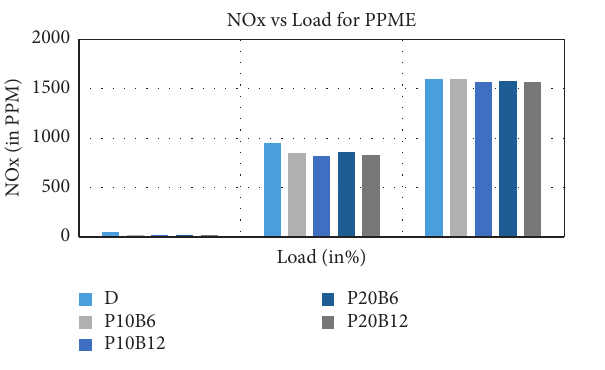
Figure 10: CO versus load for CIME samples.